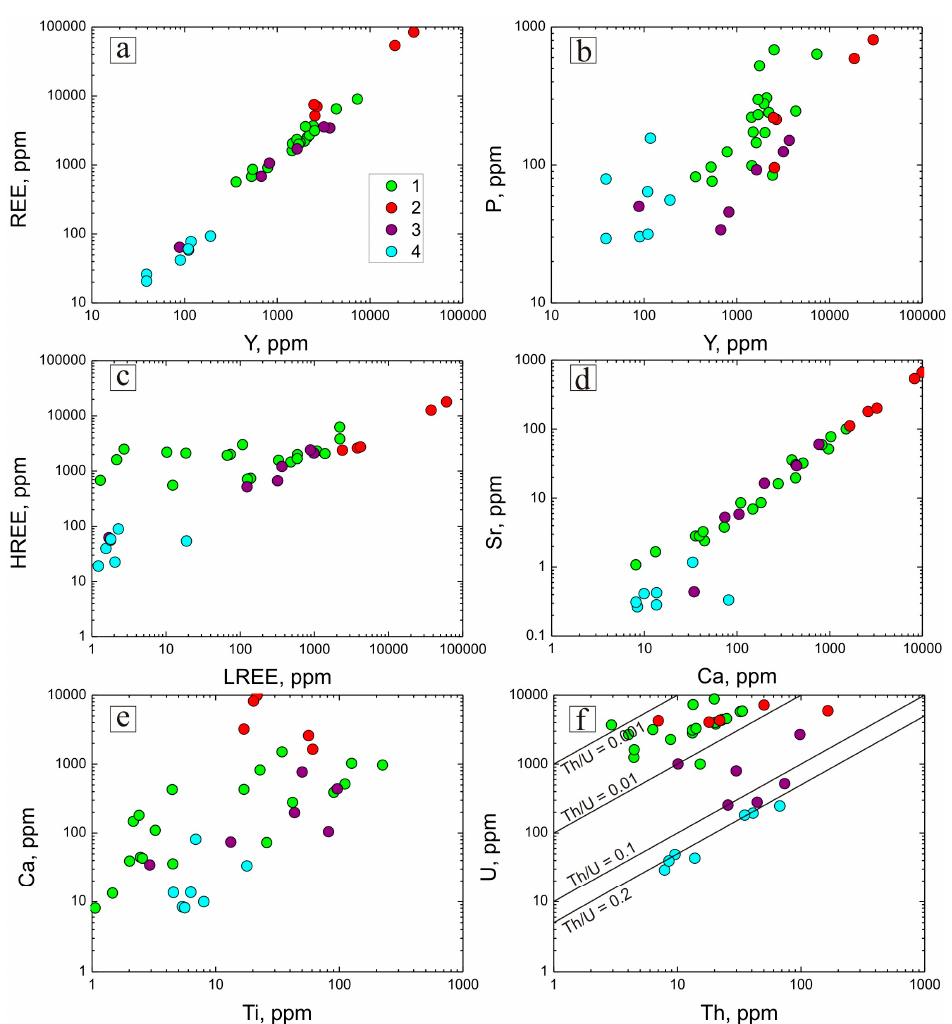
Figure 8. ( a – f ) Co-variation diagrams showing the composition of the studied zircons. 1—dark-CL pegmatite zircons (main population); 2—dark grey in BSE alteration zones in zircons; 3—inherited zircon cores; 4—zircons with sectorial (mosaic) in CL zoning.